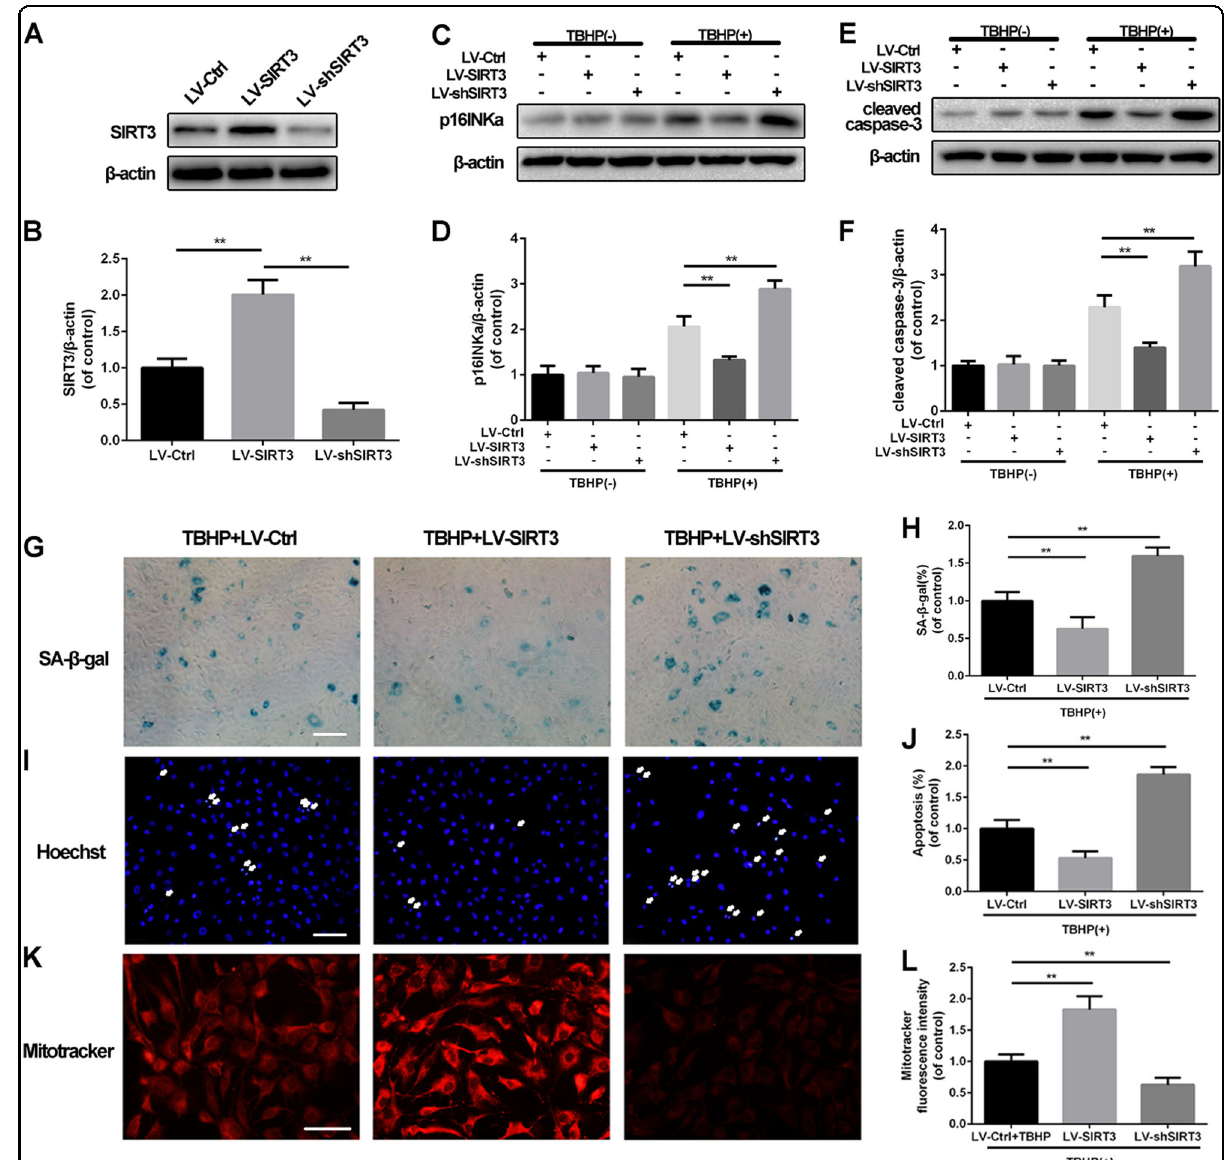
Fig. 2 The effects of SIRT3 knockdown and overexpression on apoptosis, senescence, and mitochondrial dysfunction under oxidative stress in rat NPCs. a , b Successful knockdown of SIRT3 in rat NPCs was established using LV-shSIRT3. c , d The effects of SIRT3 on the cleaved caspase-3 levels under conditions of oxidative stress. e , f The effects of SIRT3 on the p16INKa levels under conditions of oxidative stress. g , h Representative images of SA- β -gal staining of NPCs from different groups. Scale bar: 50 μ M. i , j The nucleus morphology was detected using Hoechst 33342. Scale bar: 50 μ M. k , l Mitochondrial membrane potential of rat NPCs was measured using MitoTracker red CMXRos. Scale bar: 50 μ M. All experiments were performed in duplicate, and data are reported as the mean ± SD. * P < 0.05, ** P <